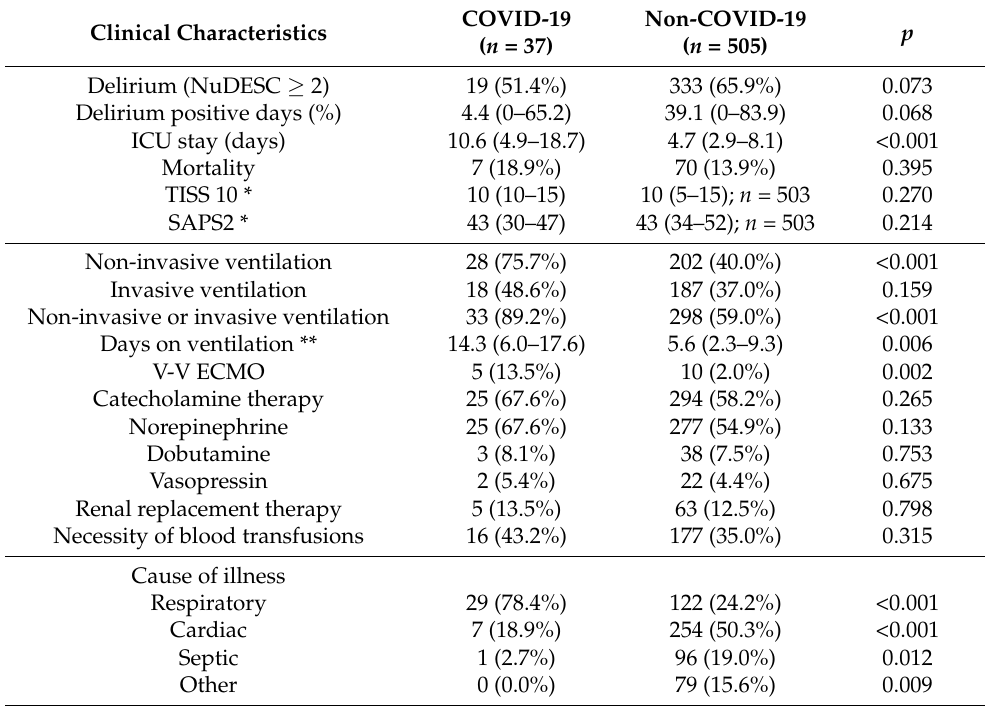
Table 2. Clinical Characteristics.